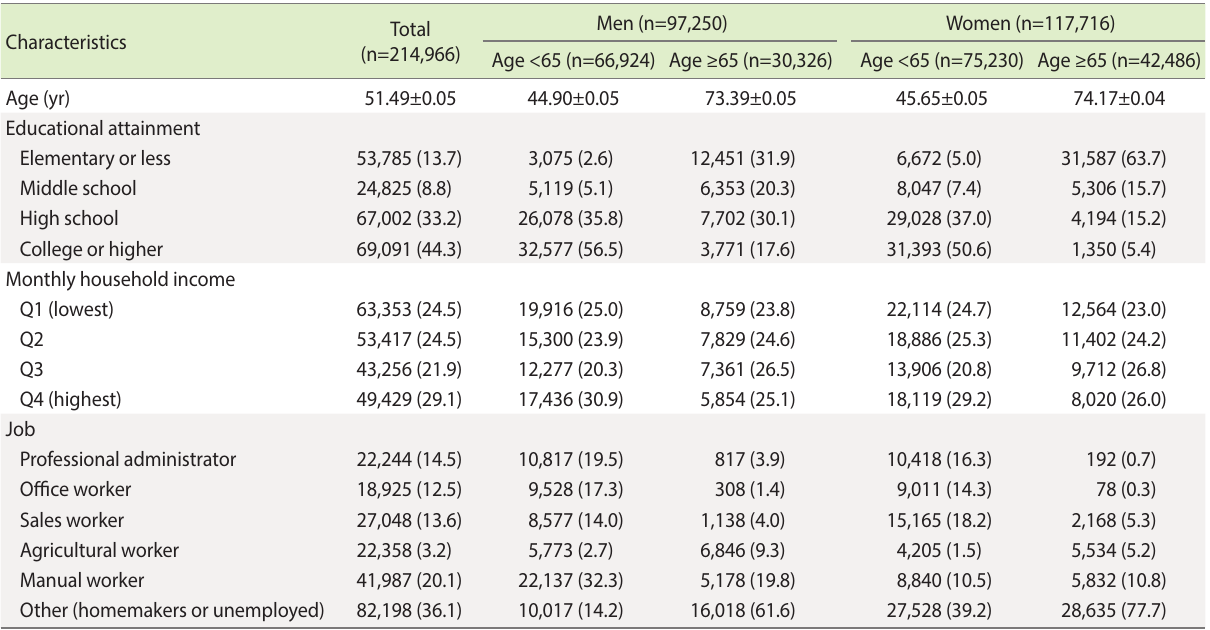
Table 1. Demographic characteristics of participants by gender and age in the Korea Community Health Survey 2020